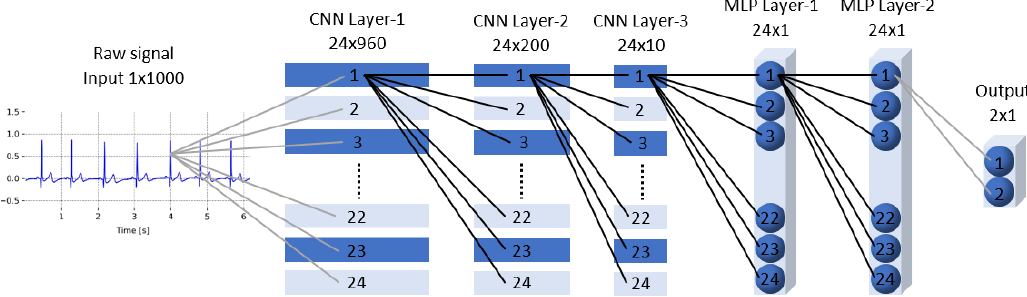
Figure 1. A sample 1D CNN with three-convolutional and two-linear layers